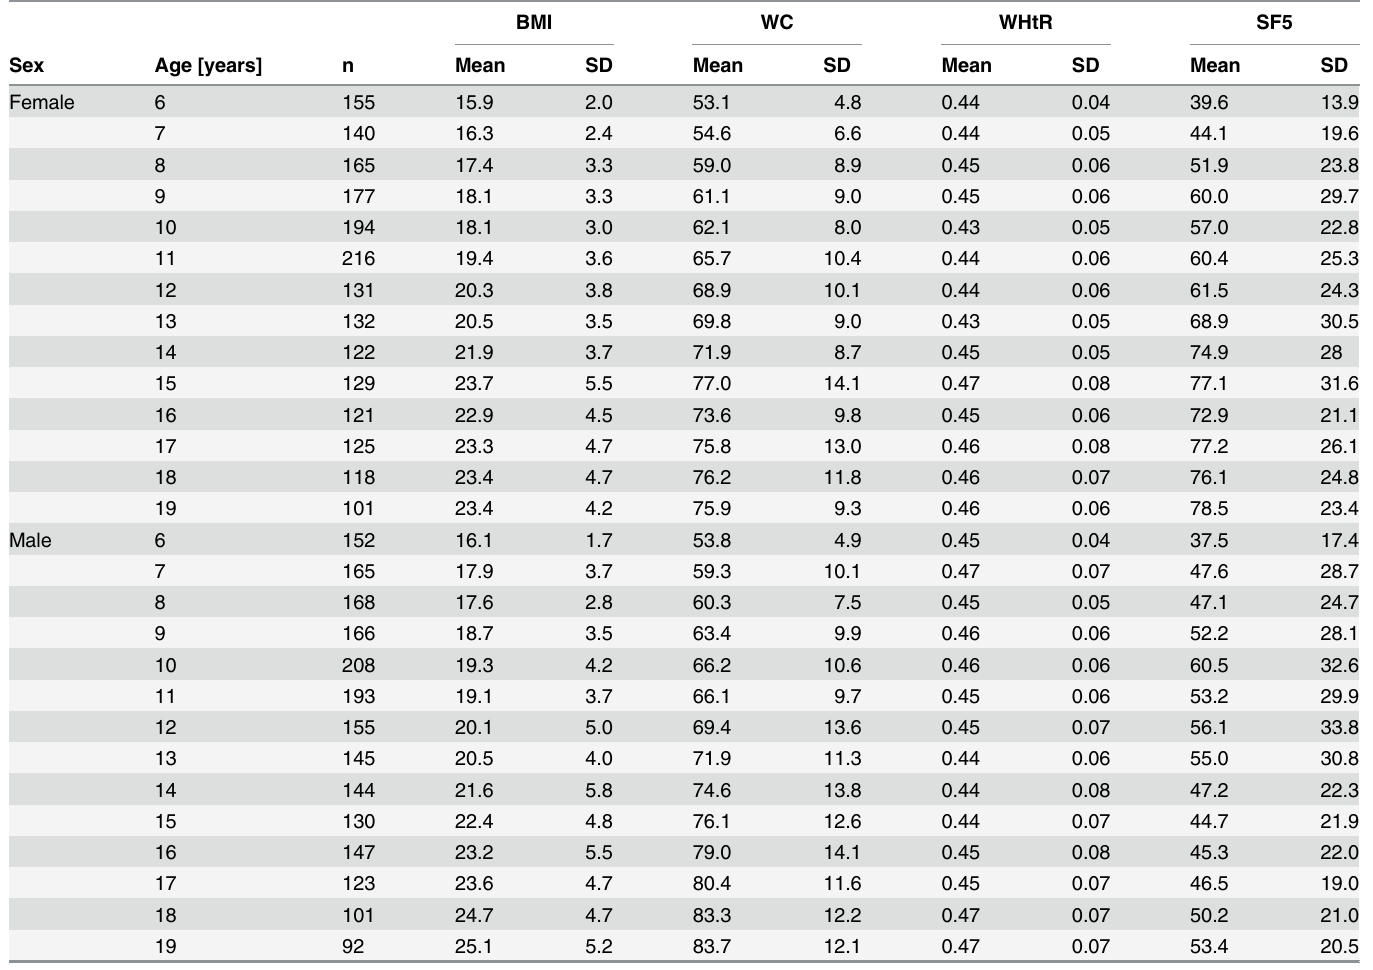
Table 1. Sample size, mean, and standard deviation for body mass index [kg/m 2 ], waist circumference [cm], waist-to-height ratio, and sum of 5 skinfolds [mm] for Canadian children and youth aged 6 to 19